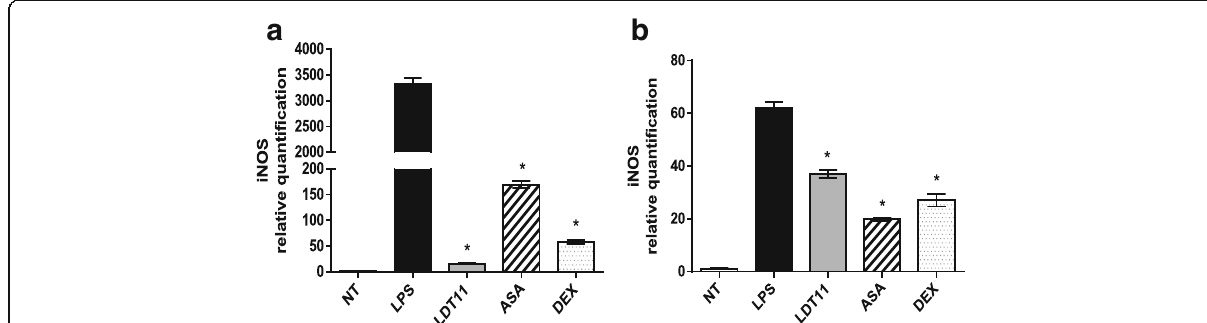
Fig. 7 Determination of the relative amount of iNOS gene transcripts in RAW 264.7 cell line for the evaluation of inflammatory response at 6 ( a ) and 24 h ( b ) post-stimulus. NT- untreated cells; LPS - LPS-stimulated cells; LDT11 - cells treated with LDT11 and then with LPS; AAS - cells treated with commercial acetylsalicylic acid and then with LPS; DEX - cells treated with the commercial anti-inflammatory Dexamethasone and then with LPS. All data are from at least three independent experiments, * p < 0.05, statistically different compared with cells LPS-stimulated